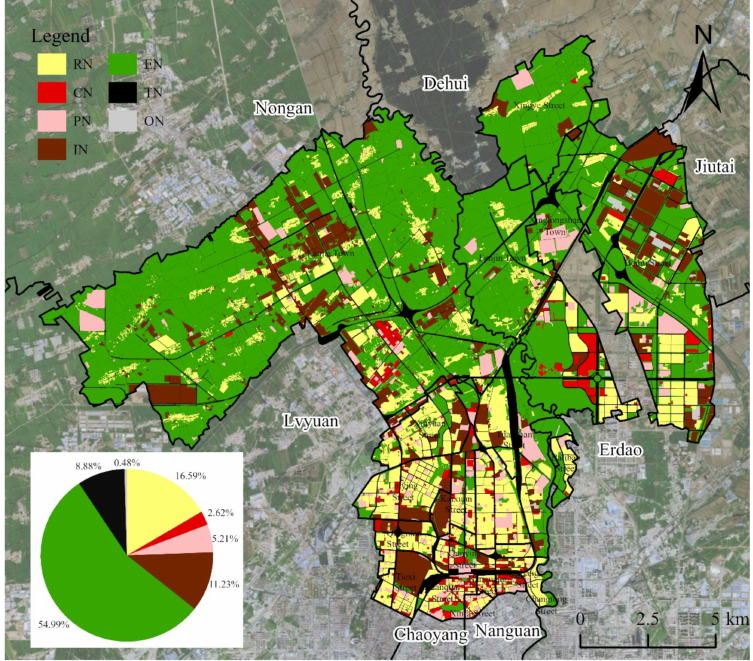
Figure 10. Spatial distribution of the urban functional classifications of Kuancheng